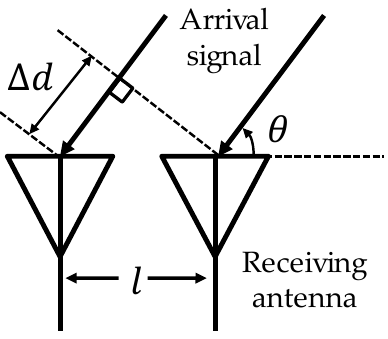
Figure 2. Signal propagation distance difference between two receiving antennas.